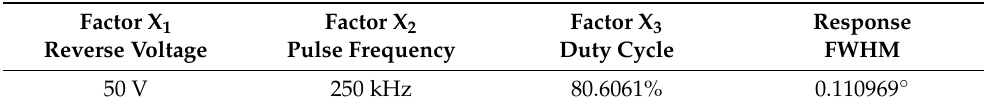
Table 5. Multiple response